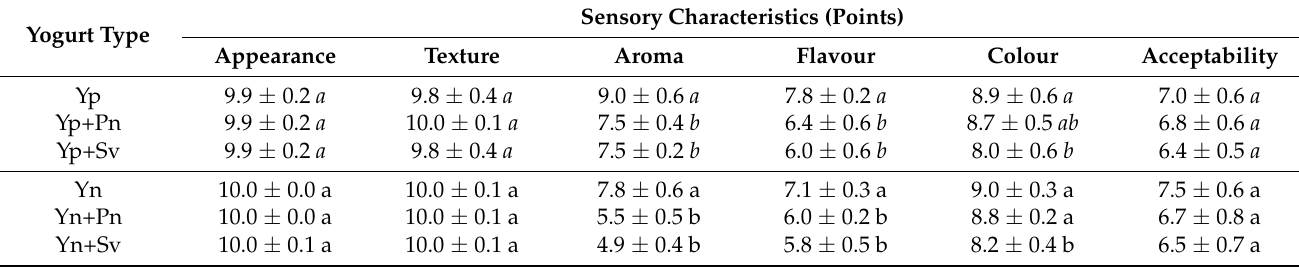
Table 8. Sensory evaluation of probiotic (Yp) and natural (Yn) yogurt with or without scCO 2 /H 2 O extracts from P. nigra (Pn) and S. viminalis (Sv) on the first day of storage *. Yogurt Type